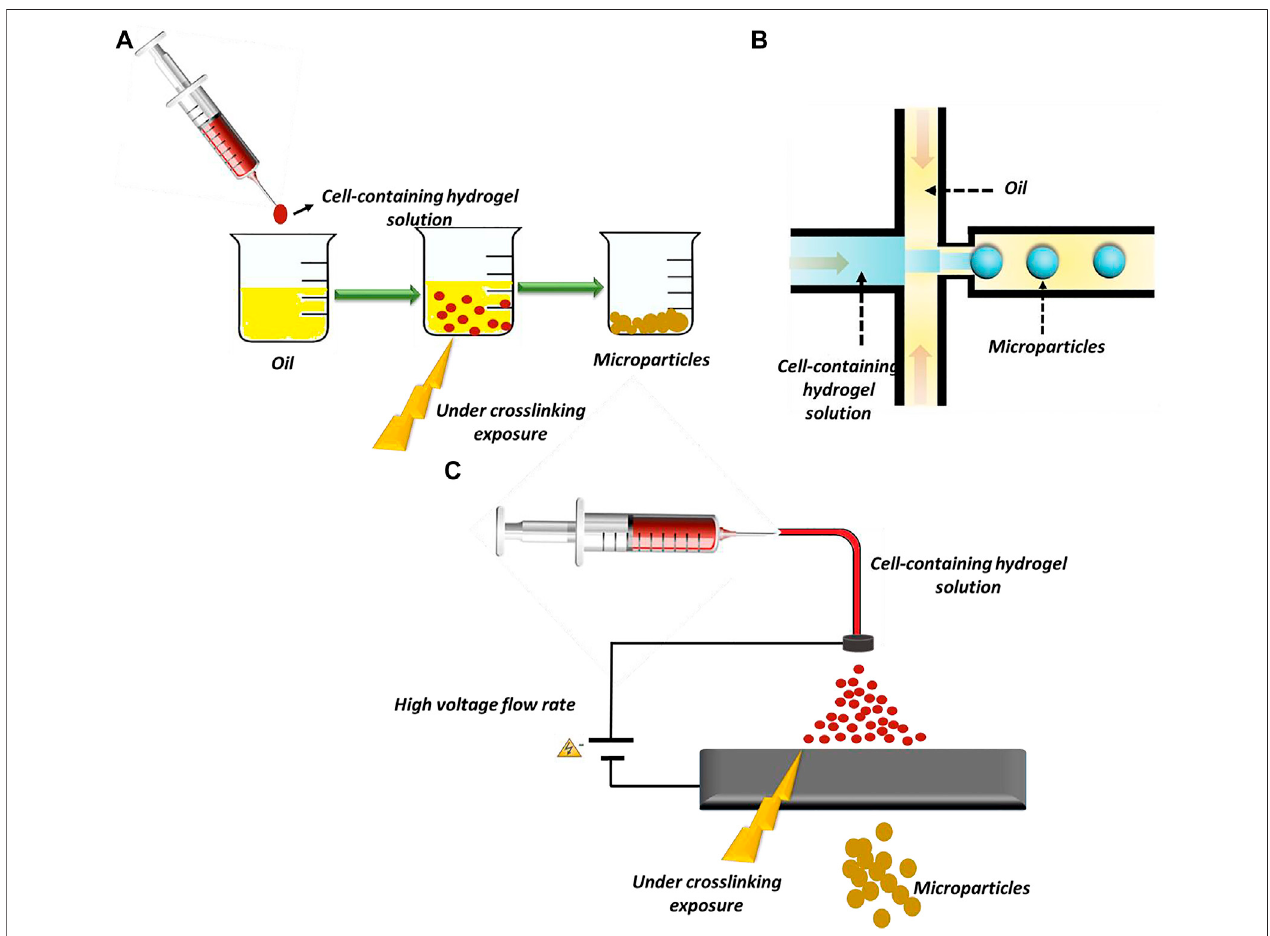
FIGURE 2 | Methods of microparticles fabrication: (A) batch emulsion technique, (B) micro fl uidic emulsion technique, and (C) EHD spraying.